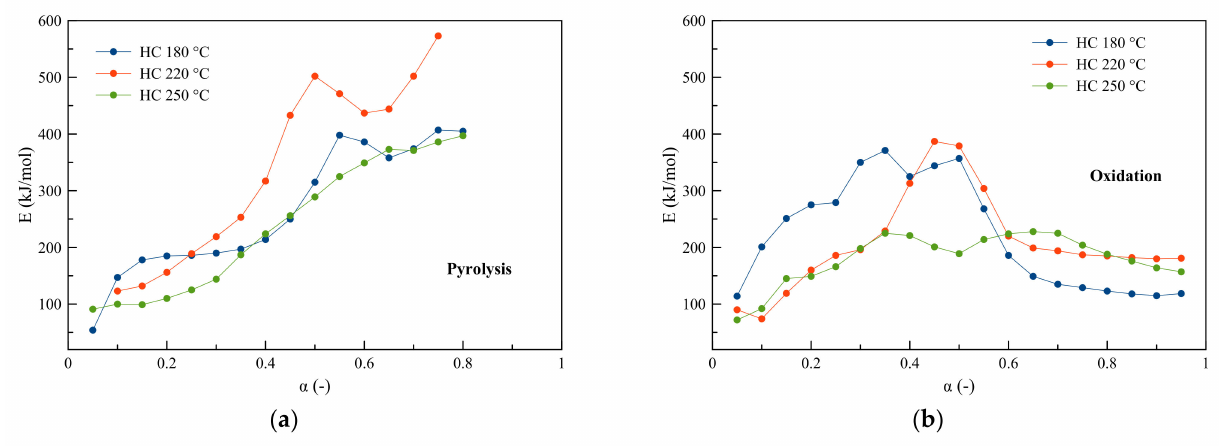
Figure 6. Distribution of E at different α of hydrochars, computed through the Miura–Maki model during ( a ) pyrolysis and ( b ) oxidation; per mol of dry feedstock.